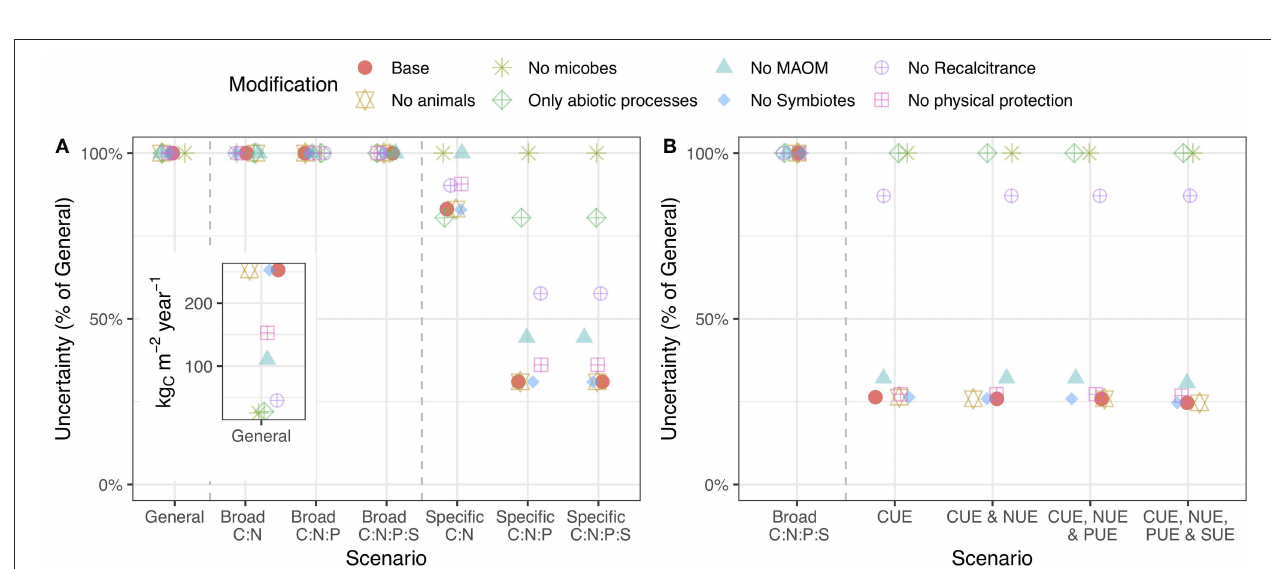
FIGURE 4 | Uncertainty in C cycling when the model structure is changed by removing the indicated pool(s). Points higher on the y-axis indicate that the addition of stoichiometric (A) or substrate use efficiency (B) information less effectively reduces model uncertainty. The inset shows raw uncertainty values in the general case. The caption for Figure 3 provides a description of the axes. A version of this plot for N, P, and S is presented in the supporting information ( Figure S3 ).